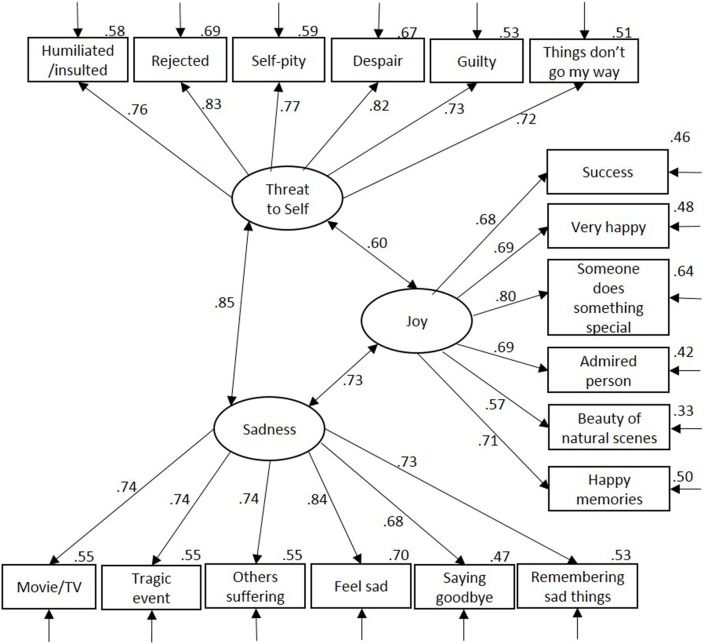
Confirmatory factor analysis for crying proneness. Residual error terms are omitted for clarity of presentation. Variance in item explained by factor is displayed top right of each item.